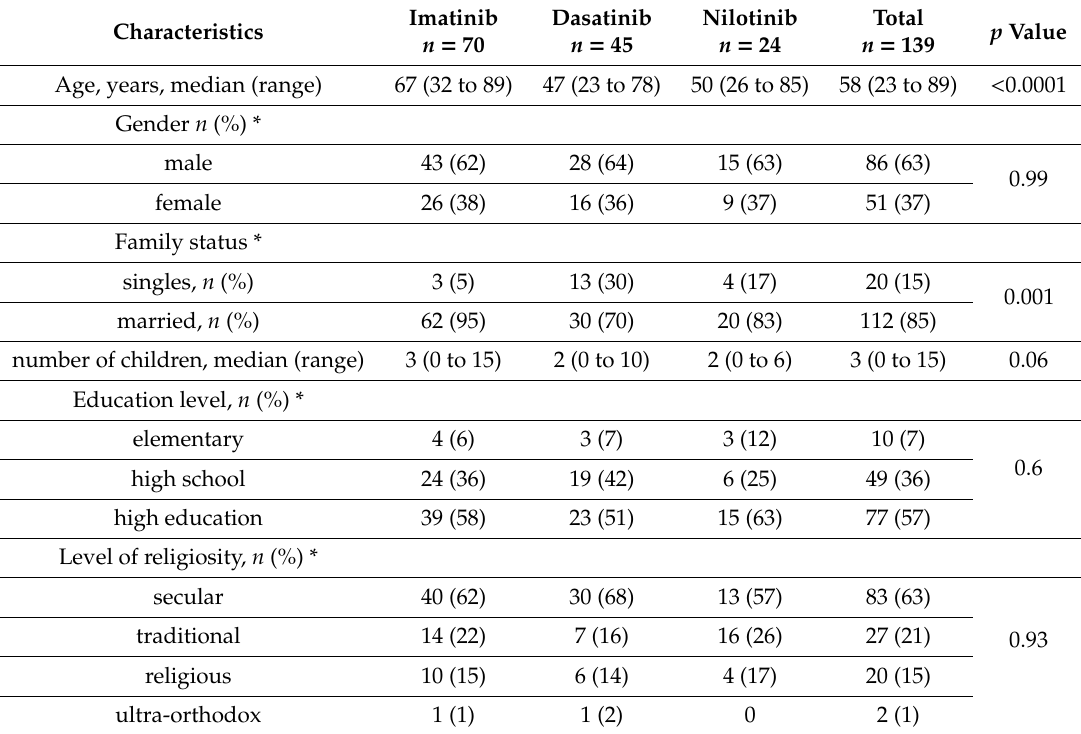
Table 1. Demographic characteristics of study population.